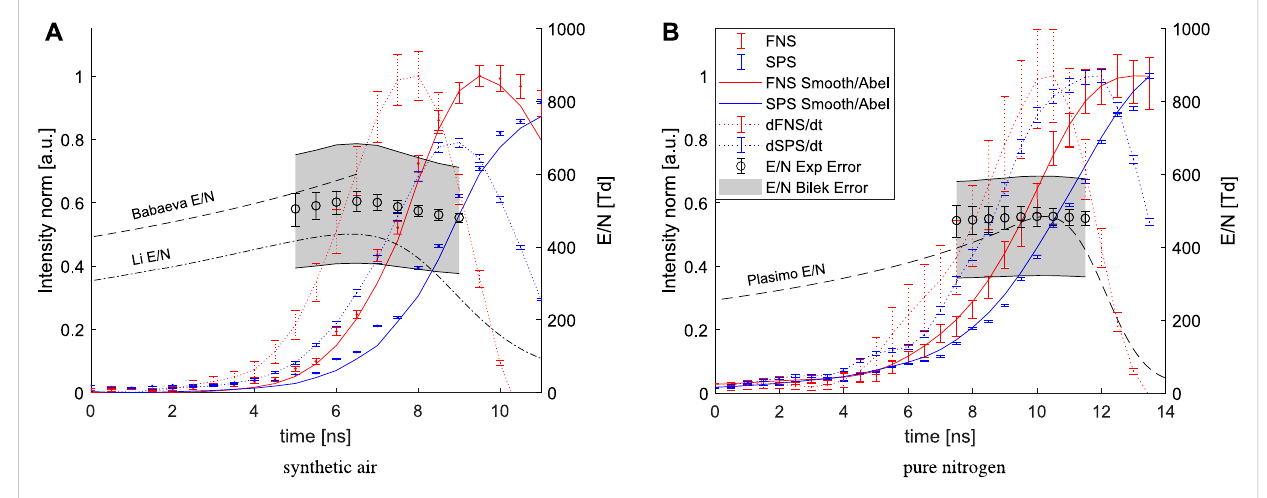
FIGURE 8 FNS and SPS signals with their derivatives, derived reduced electric fi elds and simulation results for comparison. For synthetic air (A) comparisons to theoreticalliterature(BabaevaandNaidis[16])andnumericalmodelling(Lietal[17])areincluded,whileforpurenitrogen (B) the E/N curveusedasinputof theglobal model isindicated. Red and blue solid lines plot smoothed data for pure nitrogen and Abelinverted data for synthetic air, otherwise thelegend is shared between the fi